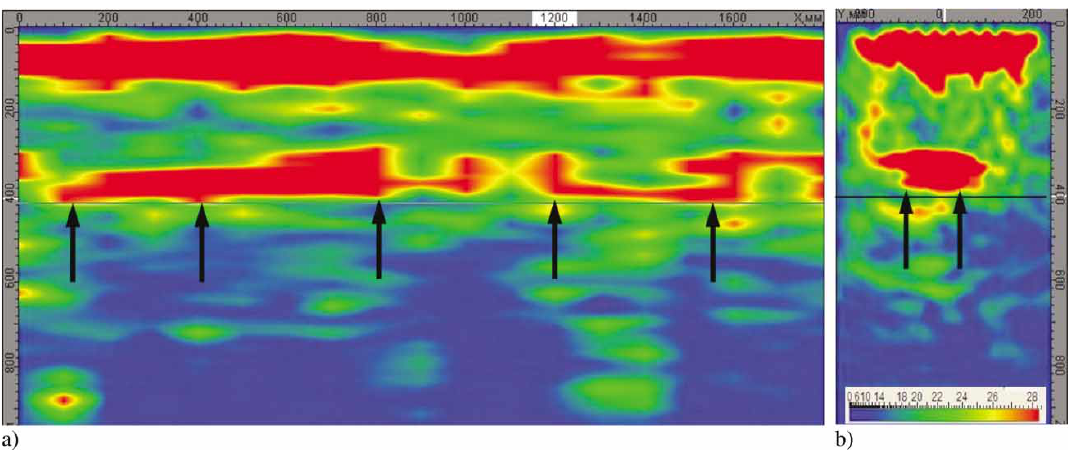
Fig. 11. Exemplary results obtained in measuring place no. 19: (a) image D; (b) image B